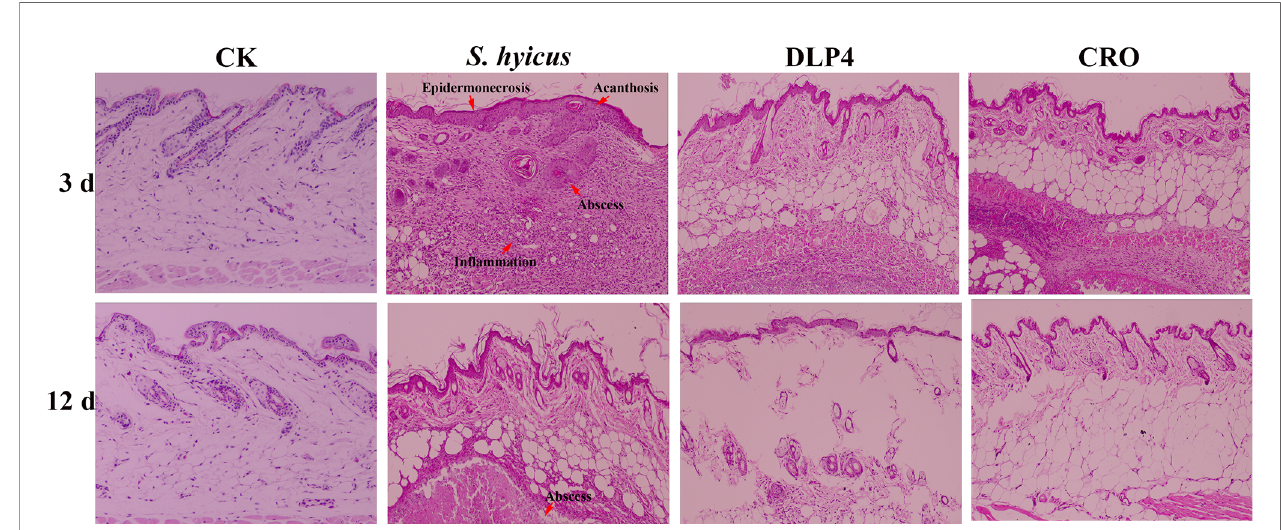
FIGURE 7 | The protective effect of DLP4 on mice skin lesion induced by S. hyicus ACCC 61734. Histological assays of skin abscesses from mice (magni fi cations, ×100) at 3 and 12 d. CK: the uninfected mice; S. hyicus : the infected mice without treatment; and treatment groups with DLP4 and ceftriaxone (CRO),